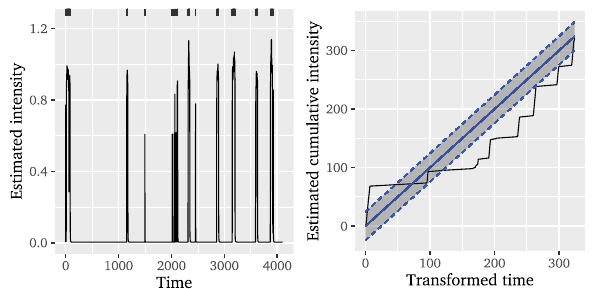
Figure 3. Estimated intensity and cumulative intensity of the Hawkes-POT model (with ETAS decay). Ticks on the upper axis represent event occurrences. 95% confidence bands are based on the Kolmogorov–Smirnov statistic